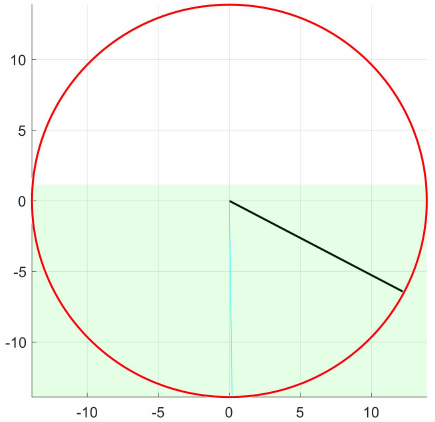
Figure 7. Direct velocity to the destination. The black radius (southeast bound) corresponds to the current velocity. The blue radius (south bound) is the direct velocity, which in this case becomes final since it is found inside the green box.